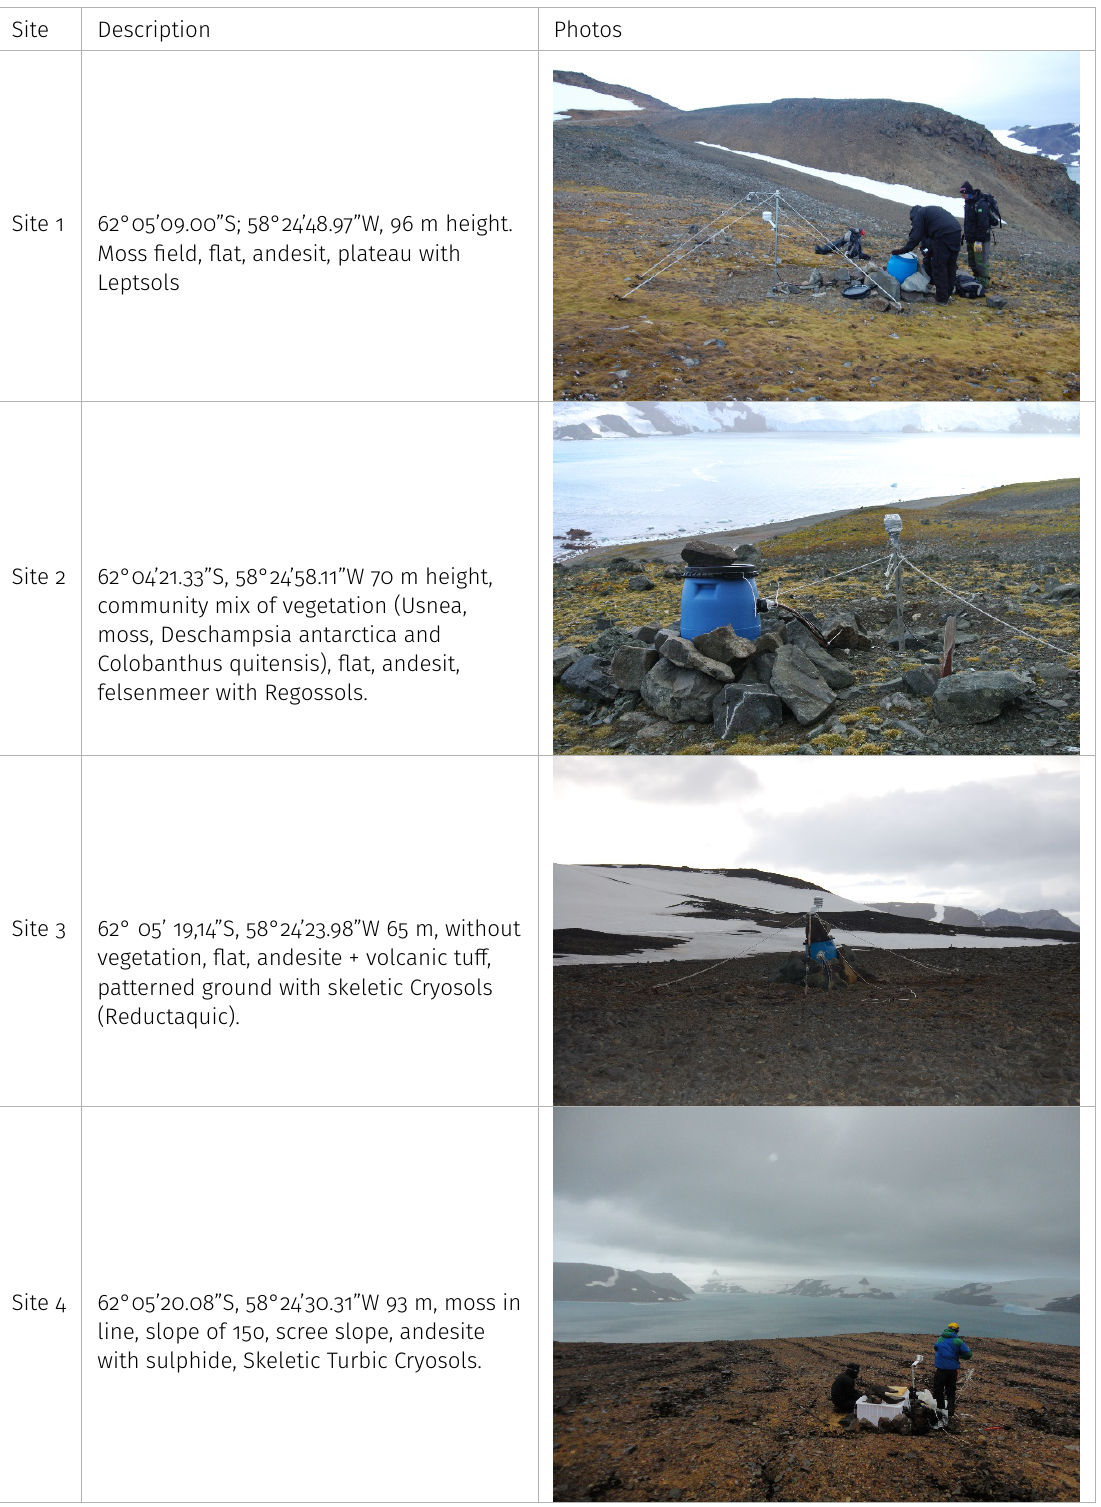
Table I. Description of the studied sites in Keller